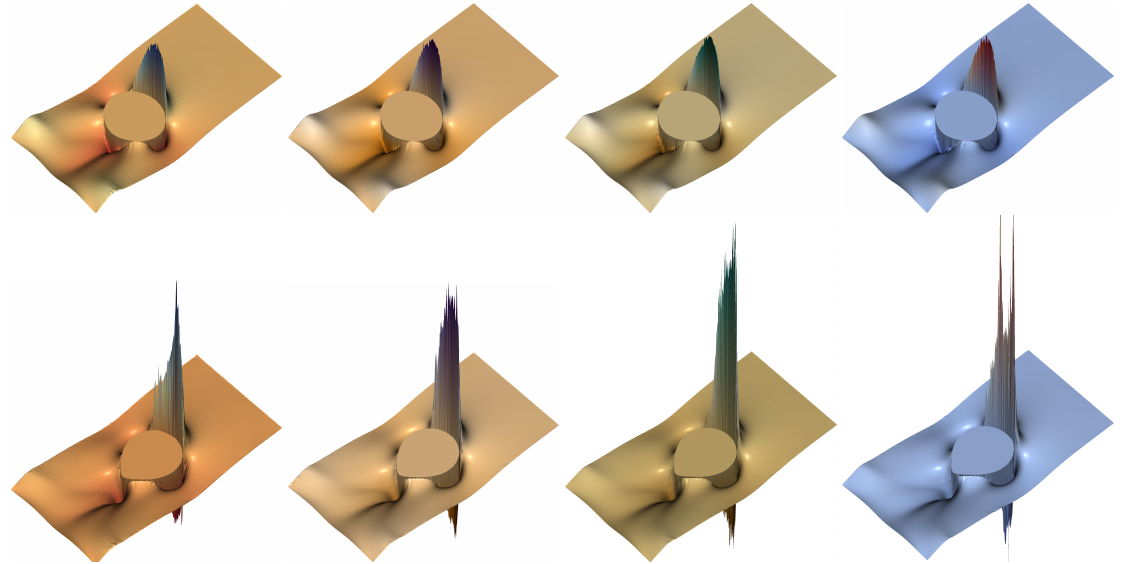
Figure 12. Representation of the normal stress difference of the polymer stress tensor, τ p ,11 − τ p ,22 , for the Hookean dumbbell model (Oldroyd-B) with c = 5, De = 3, at dimensionless instants of time t = 2 and t = 3, for variable types of CSRBF. From left to right: ϕ 3,0 , ϕ 3,1 , ϕ 3,2 , ϕ 3,3 . Top row: t = 2; bottom row: t =